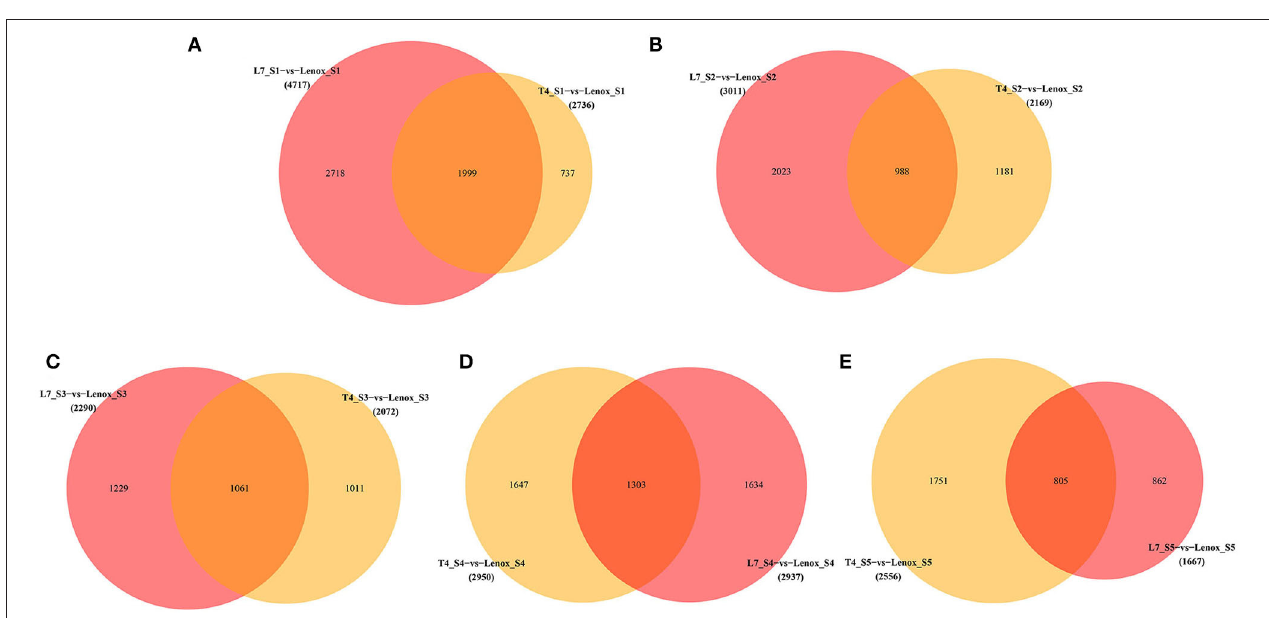
FIGURE 5 | Venn diagrams of differently expressed genes in Longyou-7 (L7) and Tianyou-4 (T4) compared to Lenox in the same stage. (A) S1 stage, (B) S2 stage, (C) S3 stage, (D) S4 stage, and (E) S5 stage.